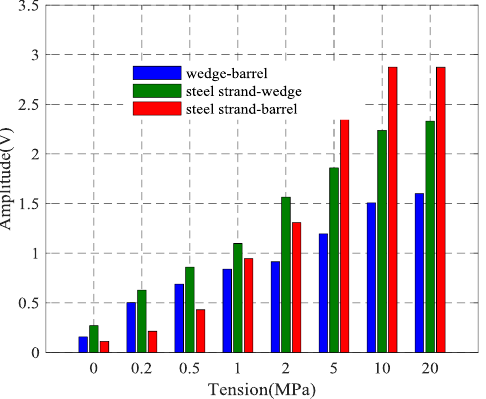
Figure 15. Three kinds of interface focused signal based on the time reversal method.